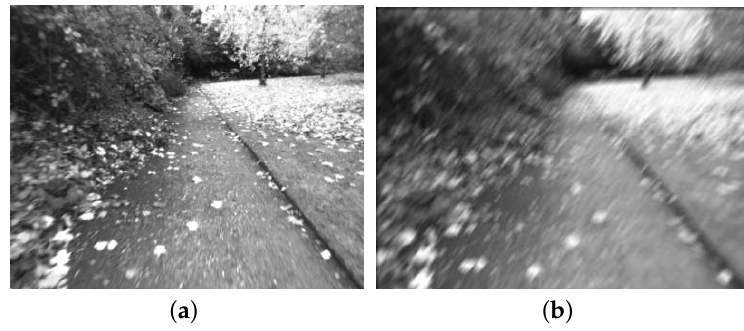
Figure 7. ( a ) Clear image sample in the original NewCollege dataset; ( b ) Image sample after adding blurred noise in the NewCollege dataset.